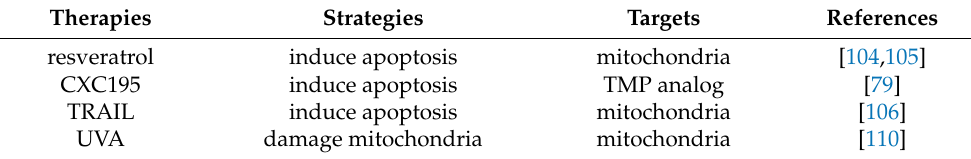
Table 1. Cont. Therapies Strategies Targets